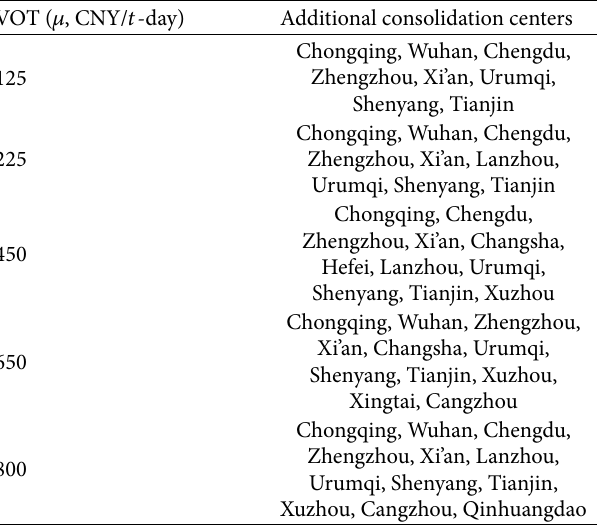
Table 6: Additional consolidation centers that should be added as the value of time (VOT)